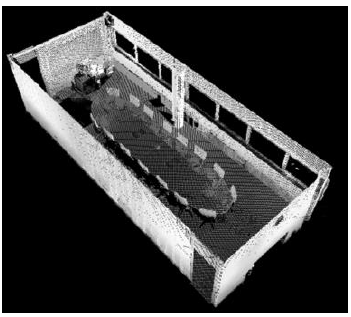
Figure 5: Perspective view of the point cloud coloured by intensity. Ceiling is toggled in order to enable visualization of indoor scene.